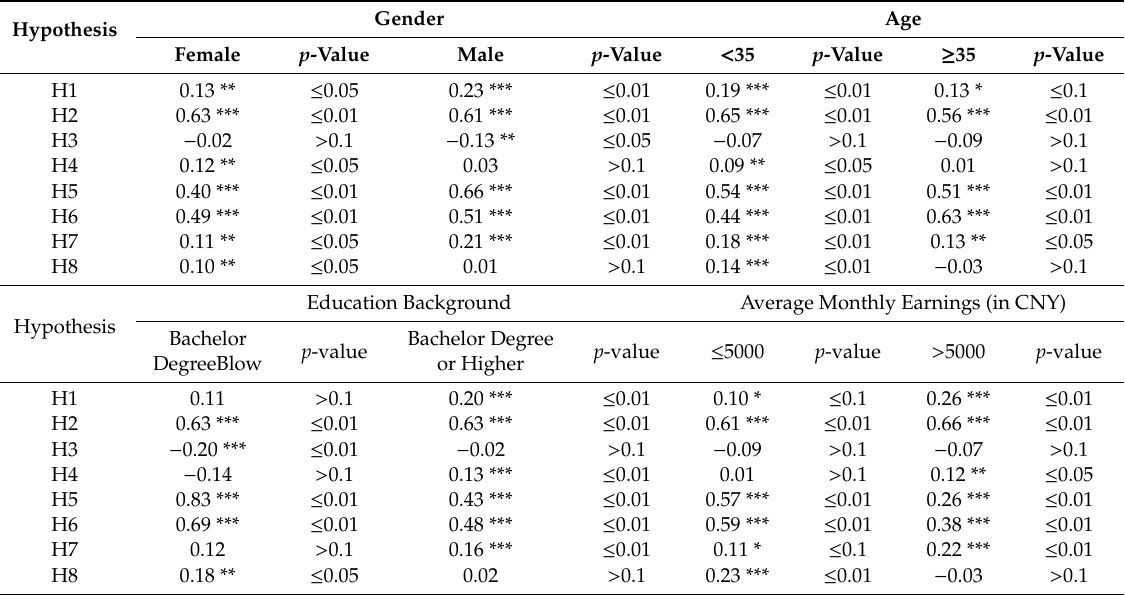
Table 7. Multiple-group analysis